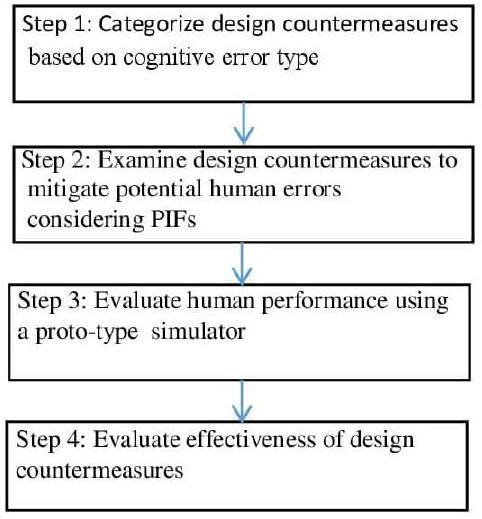
Figure 3. HRA/HFE integrated